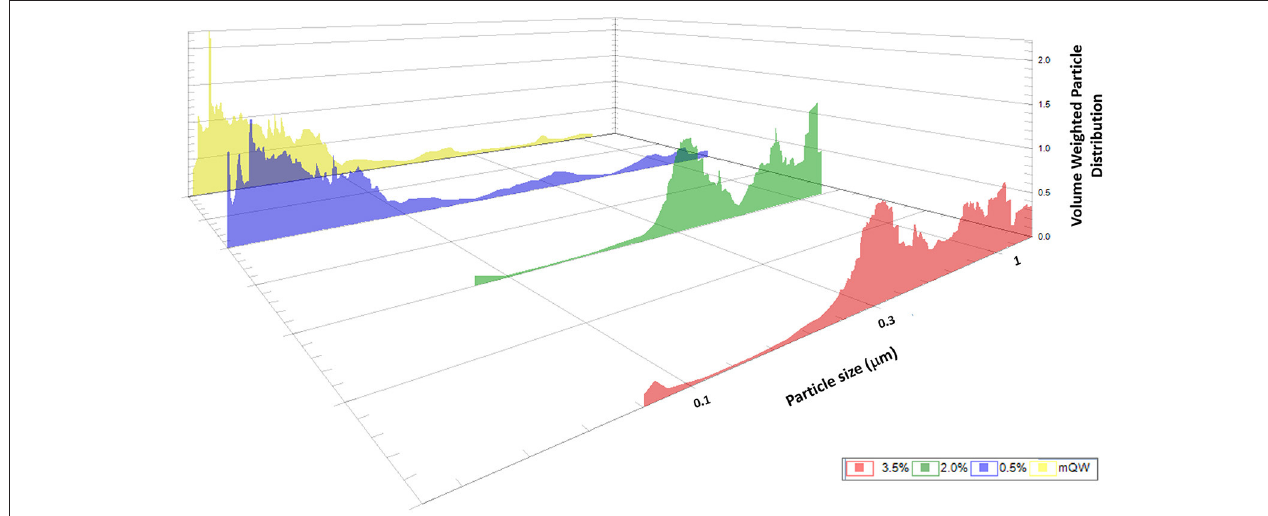
FIGURE 2 | Characterization of CuO NP dispersions in milli-Q water (mQW, T = 25 ◦ C, salinity 0%) and three saline solutions used as exposure media (T = 25 ◦ C, 0.5%-2.0%-3.5% NaCl) using LUMISizer. Vol-wt particle size distributions referred to 40 mg/l of CuO NP are showed.